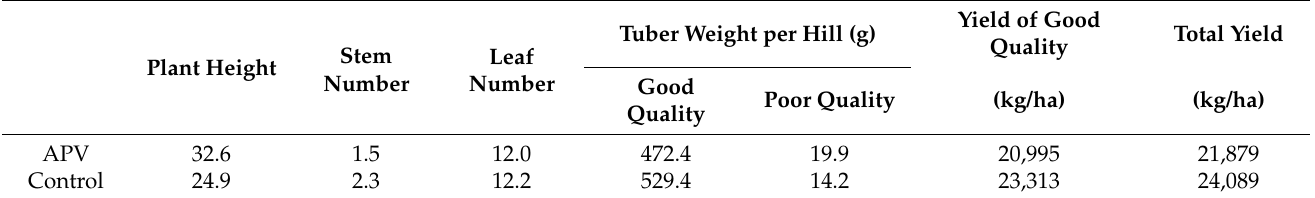
Table 4. Growth and yield of potato underneath an agrophotovoltaic (APV) system in Cheongju, South Korea,